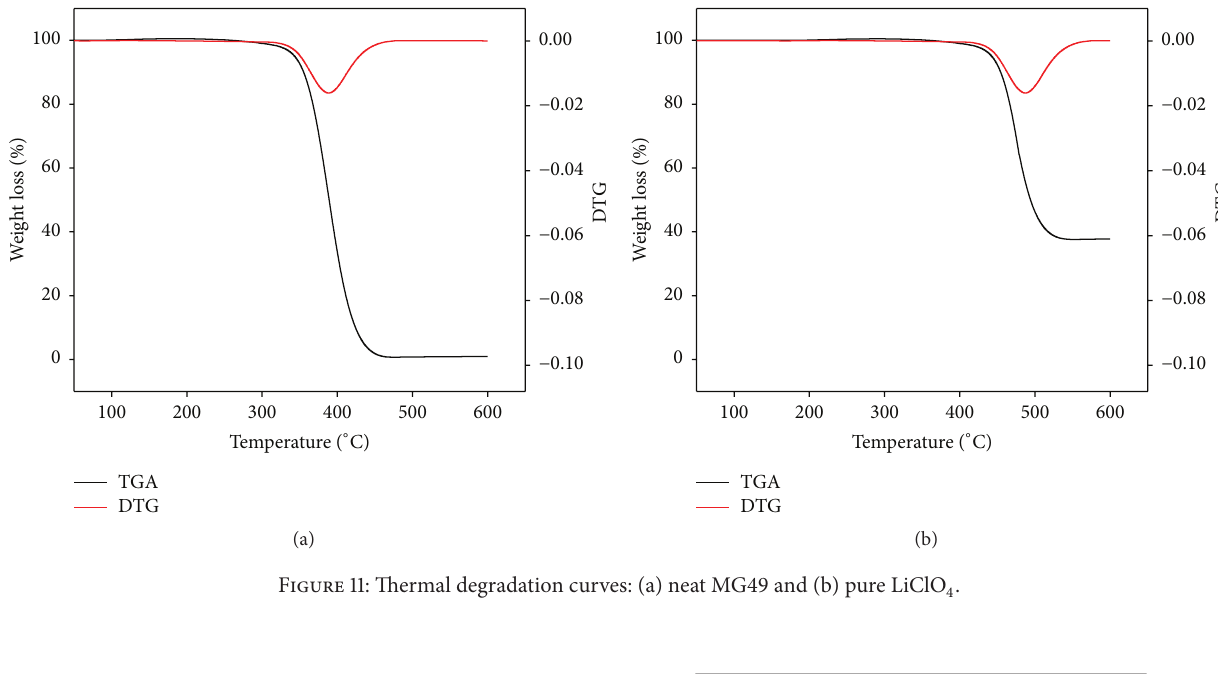
Figure 11: Thermal degradation curves: (a) neat MG49 and (b) pure LiClO 4 .